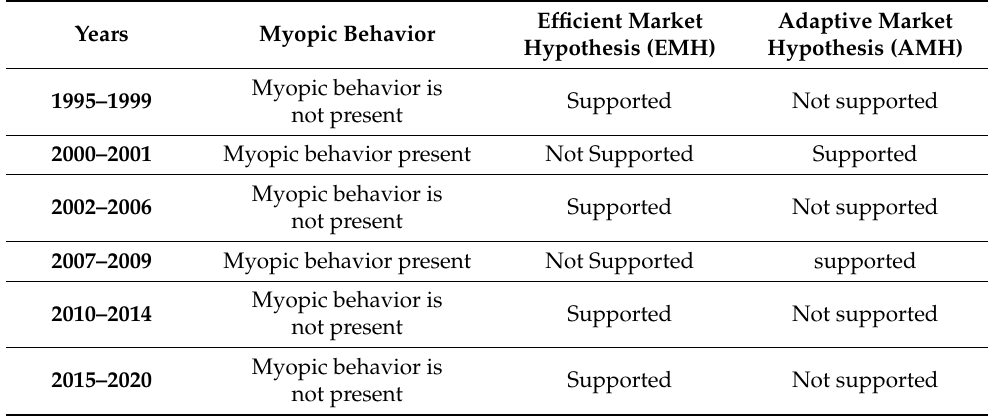
Table 3. Overall results in terms of myopic loss aversion, Efficient Market Hypothesis, and Adaptive Market Hypothesis by using Sharpe